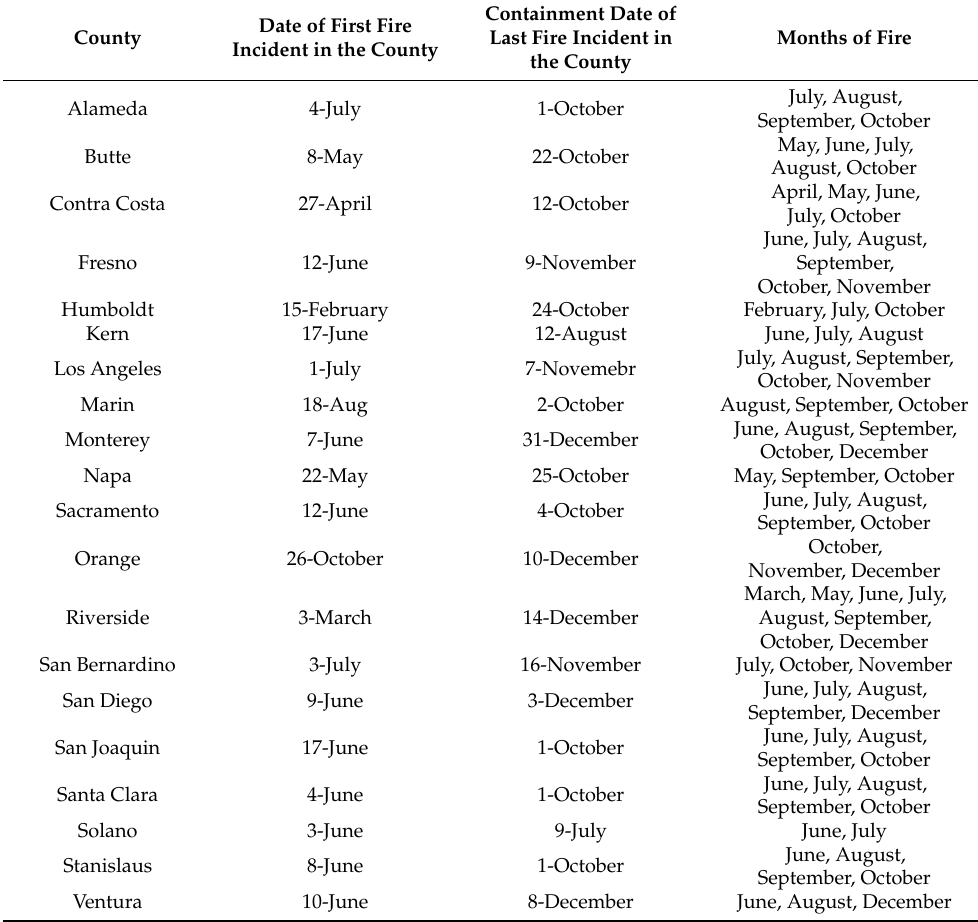
Table A1. Counties included in the study and the months with fire incidents in each (Source: fire.ca.gov accessed on 24 January 2022